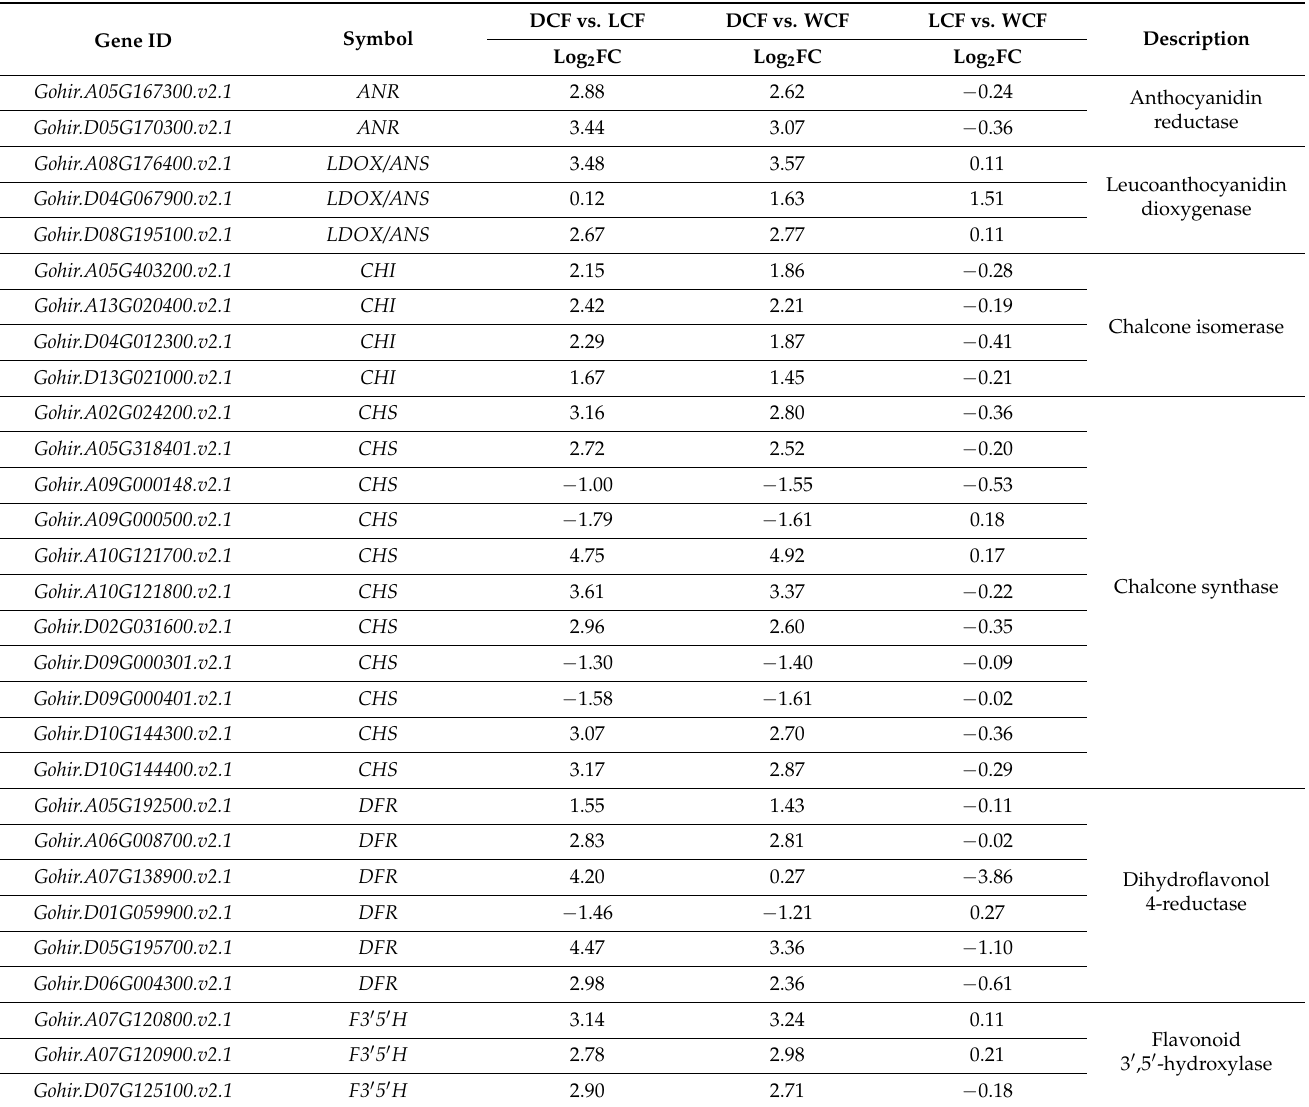
Table 1. List of the flavonoid biosynthesis pathway